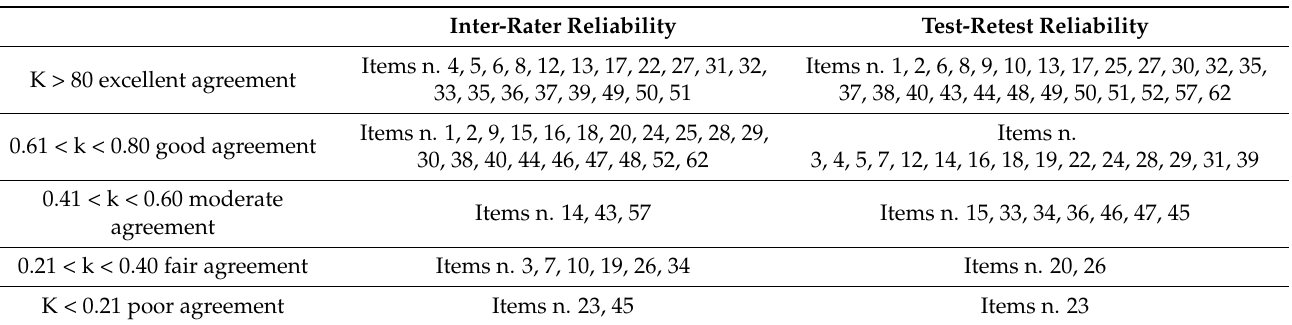
Table 3. Distribution of Kappa coefficients for the single items of the scale (items with absence of variability are not reported in the